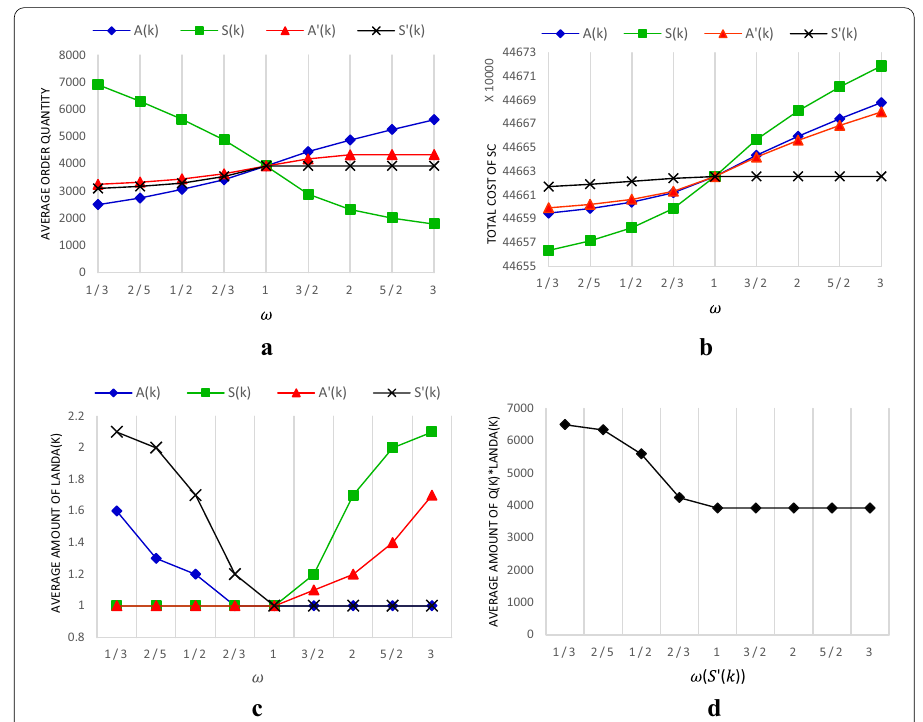
Fig. 6 The results of the sensitivity analysis for the operational parameters. Note : In the vertical axis, the average amount of each variable is defined on k, where k k Q k defined as (cid:31)